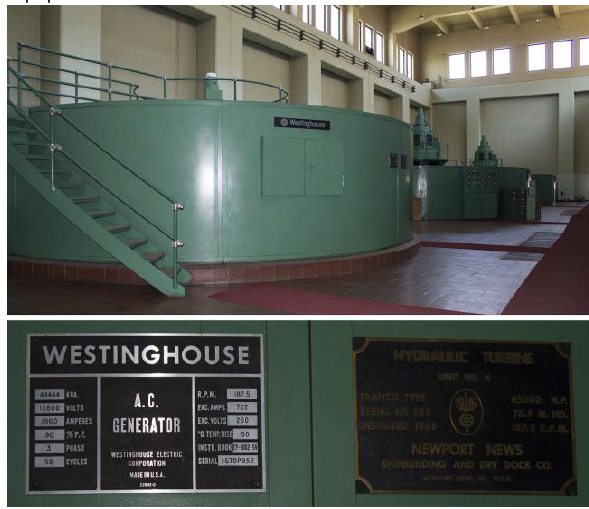
Figure 7. Sarıyar Hydroelectric Plant,